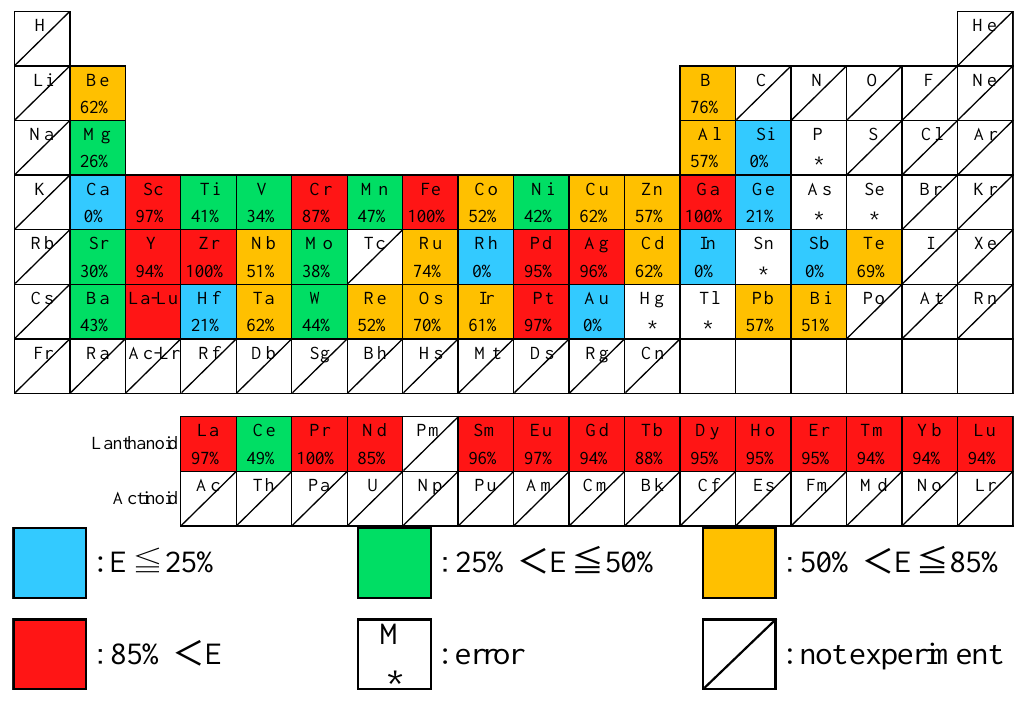
Figure 3. Summary of the extraction percentages for elemental ions with Zonyl FSA ® .